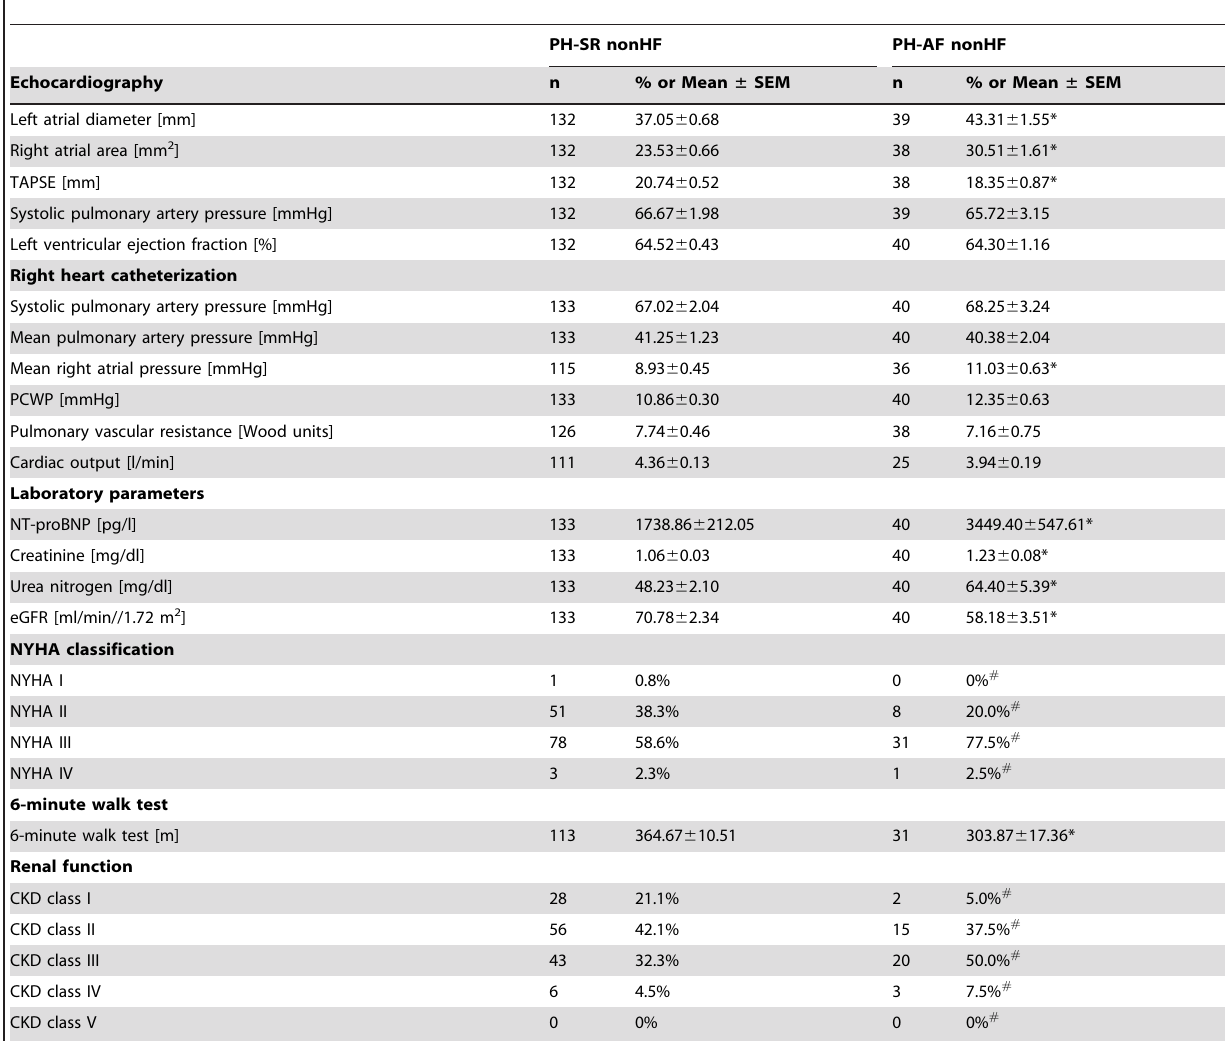
Table 4. Comparison of subgroups with SR vs. AF in PH not related to left heart disease